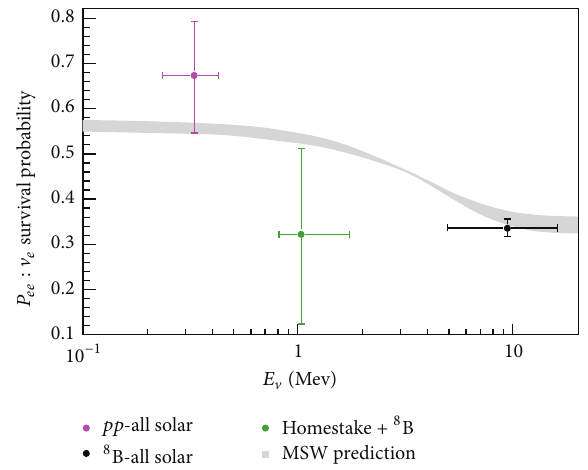
Figure 10: Solar ] 𝑒 survival probability [21] as a function of neutrino energy. The data points are from the radiochemical and the water ˇ Cerenkov experiments. The grey band is the prediction of the LMA solution in the frame of MSW